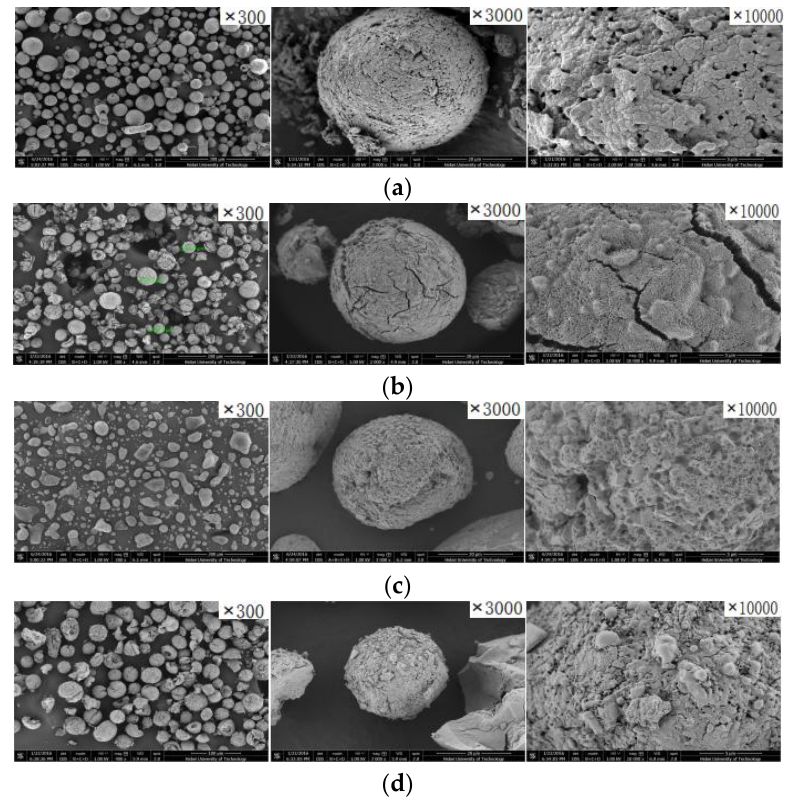
Figure 2. SEM images of support ( a ), Cat-1 ( b ), Cat-2 ( c ) and Cat-3 ( d ).